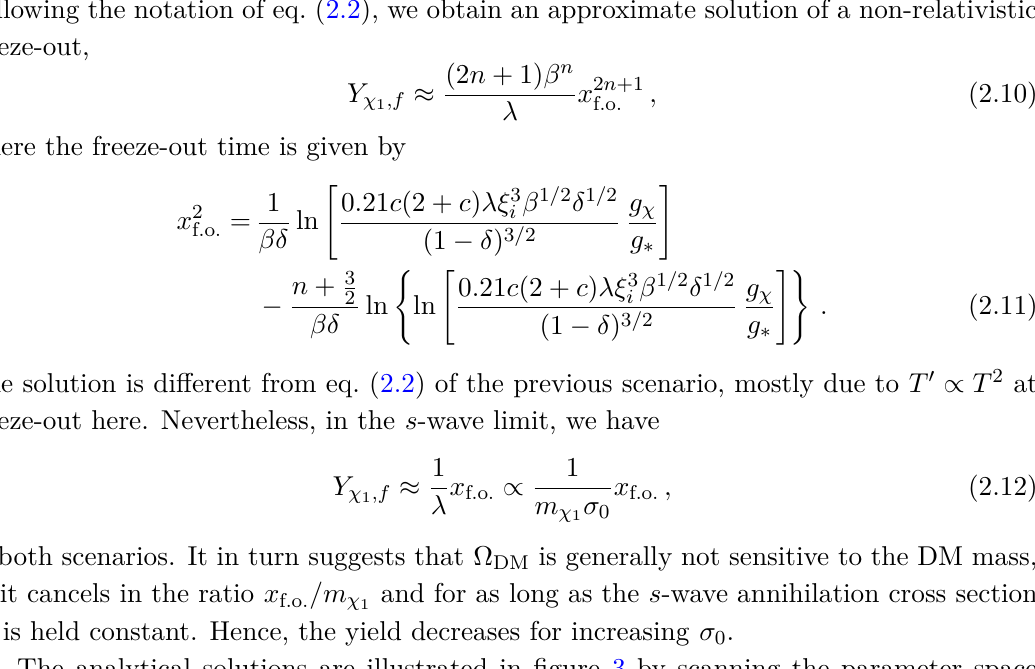
Figure 3 . Contours of x f.o. (left panel) and Y χ of section 2.2 as a function of mass splitting, δ , and the initial temperature ratio between the dark and SM sectors, ξ i . In both panels, we choose m χ dashed black lines show the observed DM abundance. The red (gray) stars depict the parameter choices used in figure 2 (figure 13), where the Boltzmann equations are solved numerically for δ = 0 . 1 and ξ i = 0 . 1